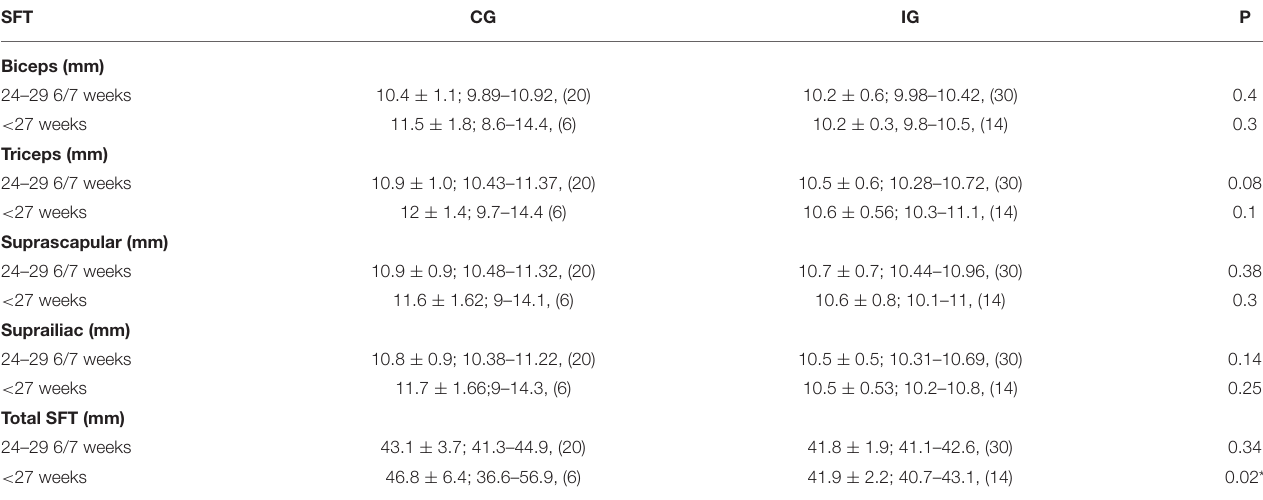
TABLE 3 | Skin fold thickness.